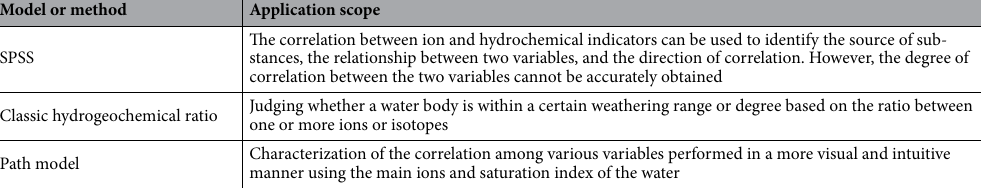
Table 6. Comparison of classic discriminant methods and the path model in hydrogeochemistry for studying chemical weathering.